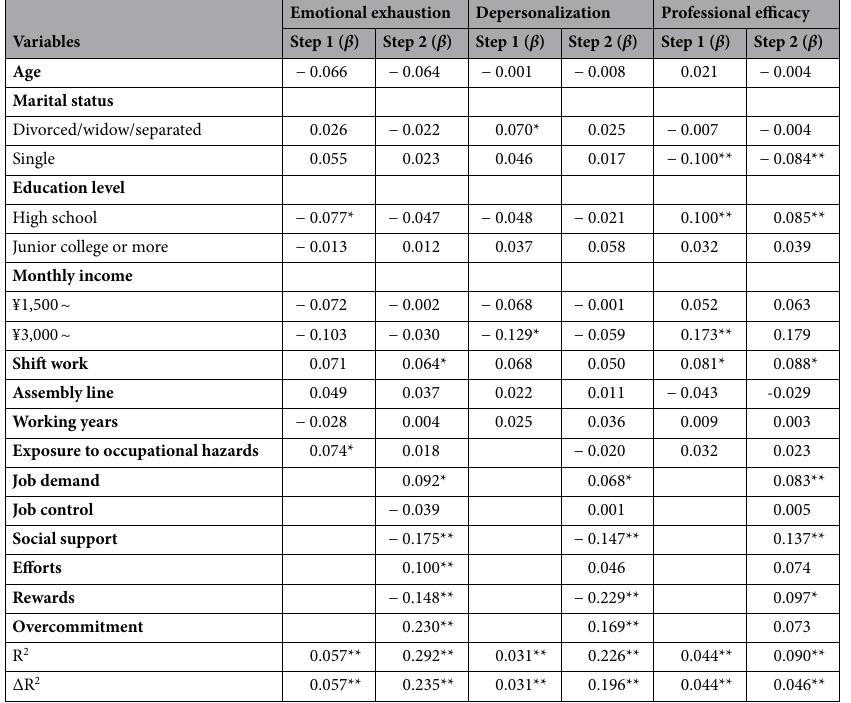
Table 4. Hierarchical linear regression analysis of the factors associated with the MBI-GS scores. * P < 0.05, ** P < 0.01.